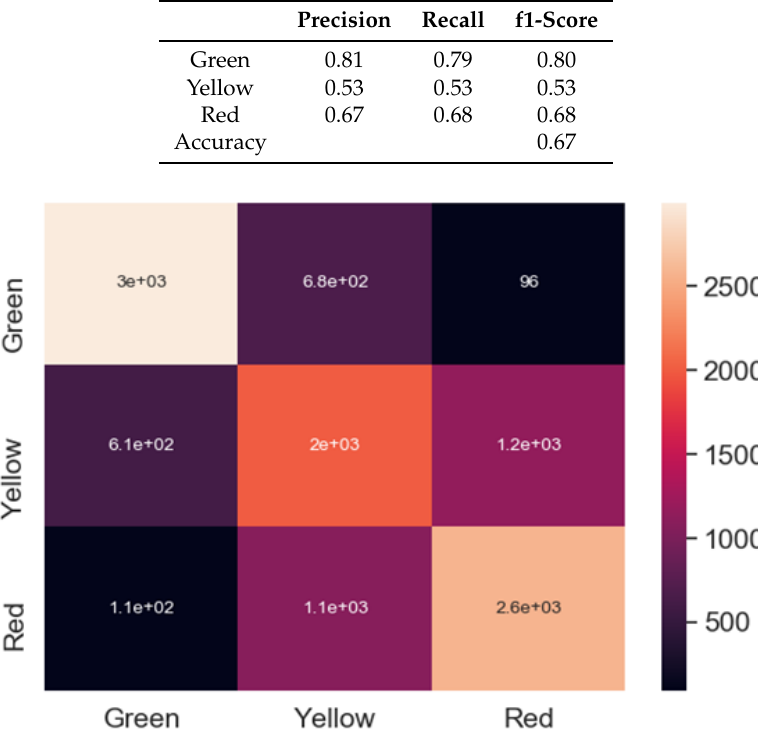
Table 2. Results for the Siamese network without using a window.